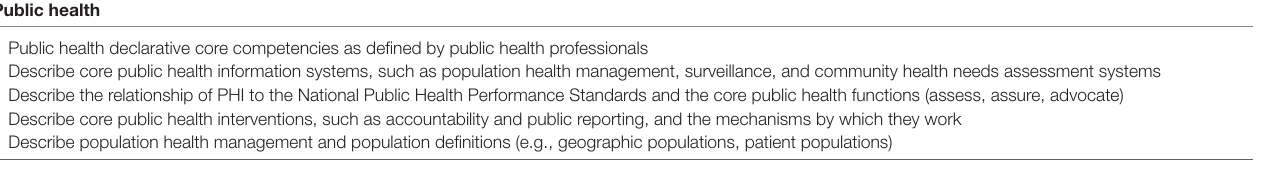
taBle 2 | Public health informatics (PHI) declarative